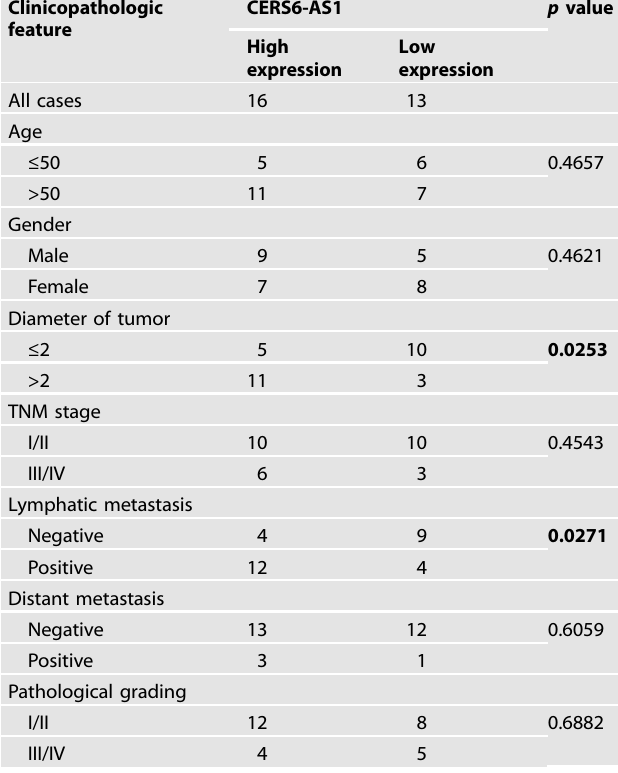
Table 1. General clinicopathological characteristics of